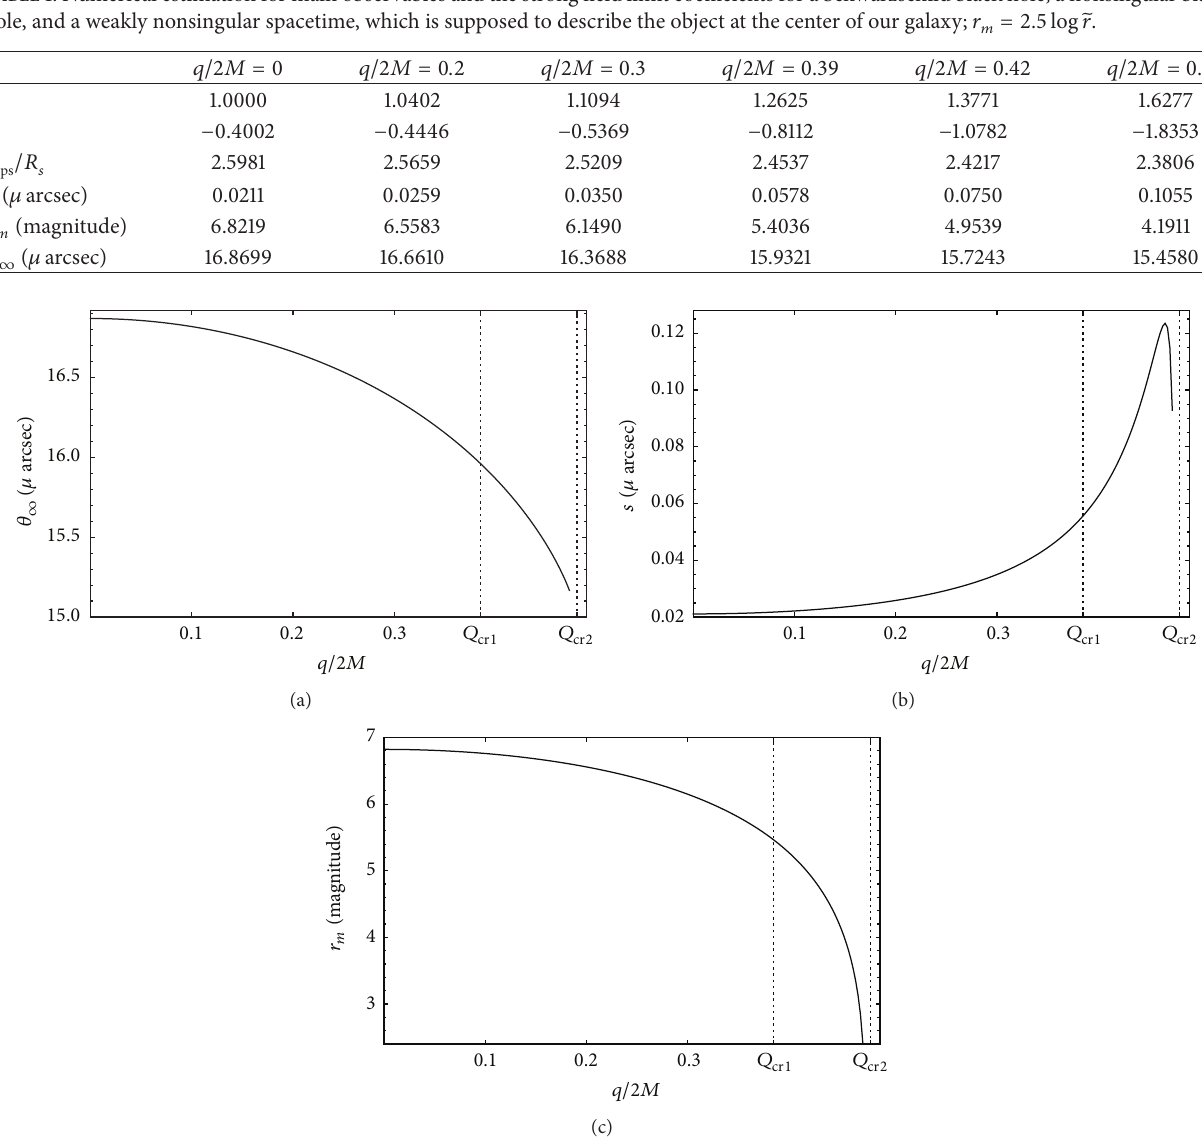
Figure 5: Gravitational lensing by the galactic center black hole. Variation of the values of the angular position 𝜃 ∞ , angular separation 𝑠 , and relative magnitudes 𝑟 𝑚 with the parameter 𝑞/2𝑀 in the nonsingular spacetime; 𝑟 𝑚 = 2.5 log ̃𝑟 .